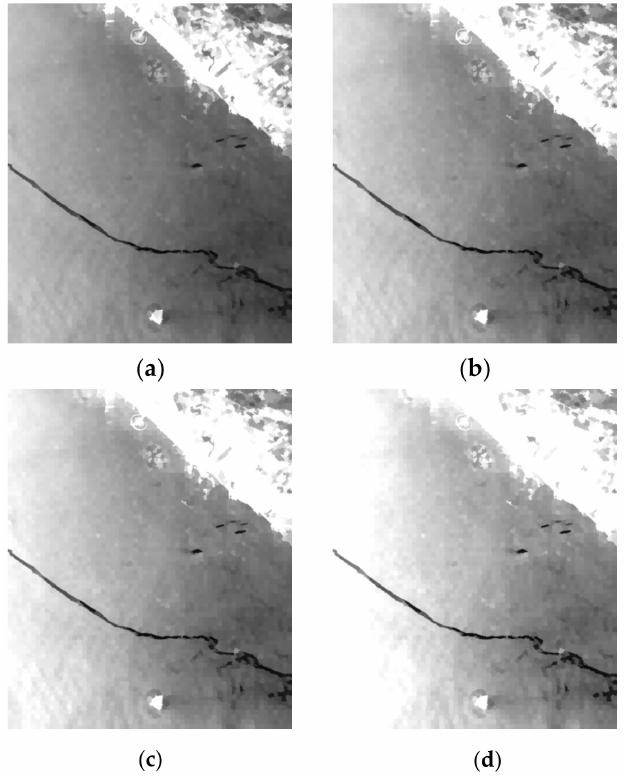
Figure 12. Image stretching results using different expansion coefficients: ( a ) 1.2, ( b ) 1.4, ( c ) 1.6, and ( d ) 1.8.